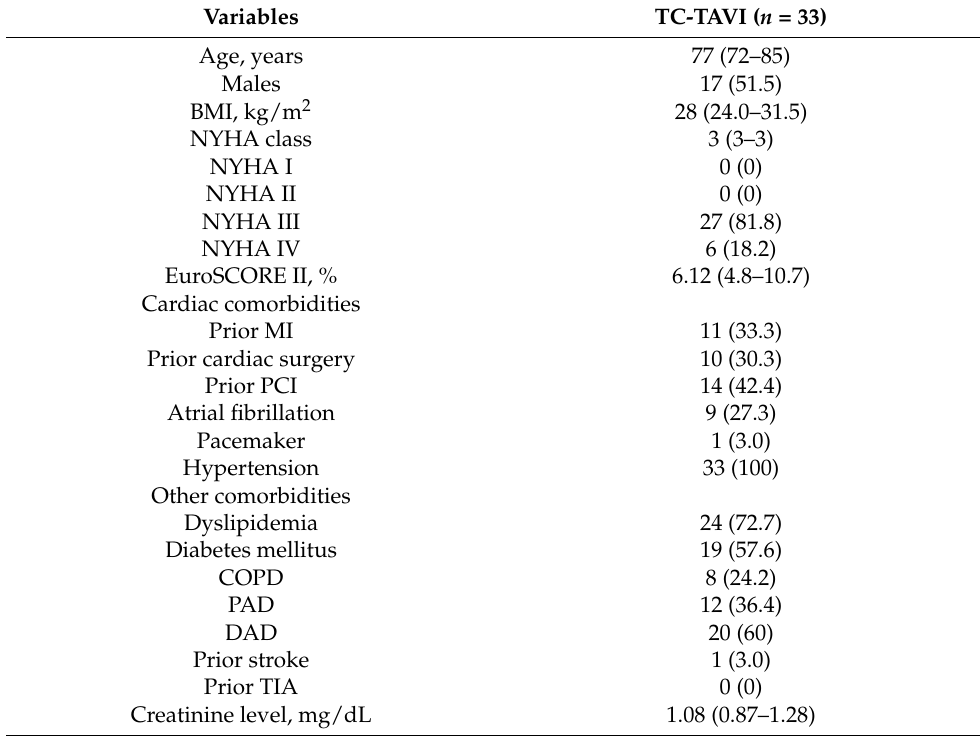
Table 1. Baseline